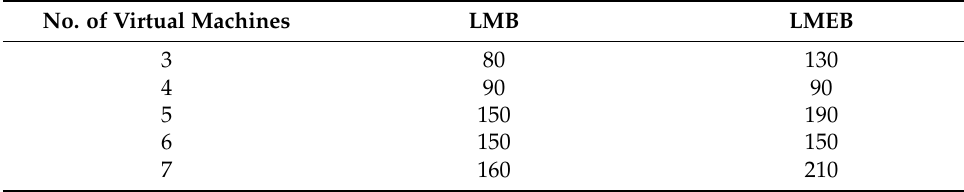
Table 10. Makespan for all scenarios in seconds.